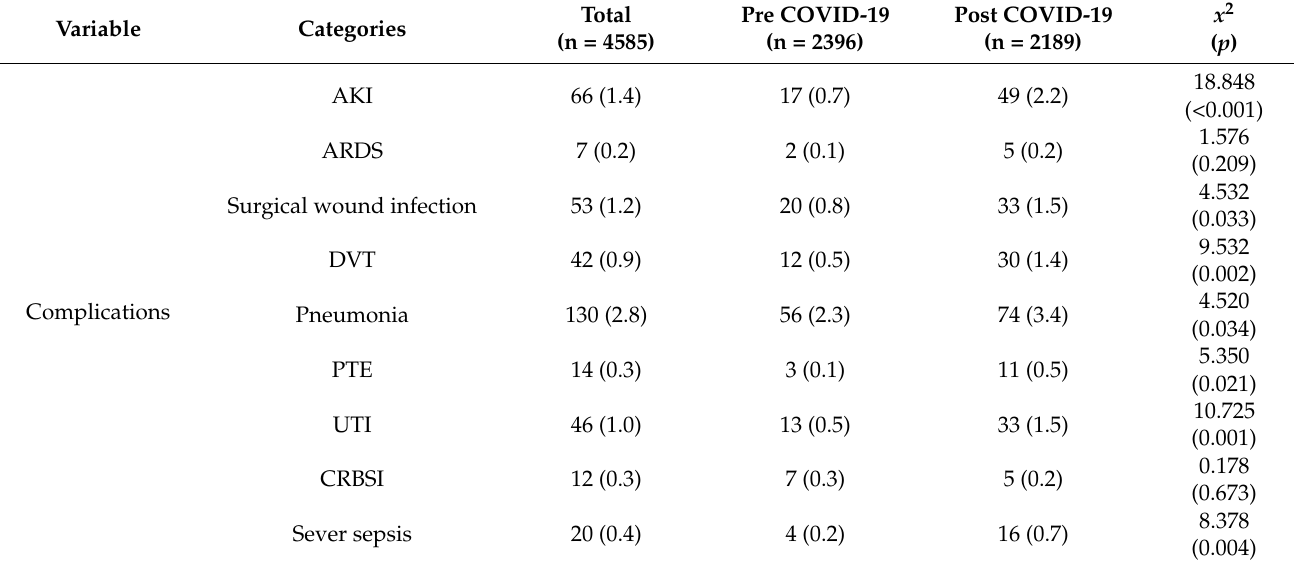
Table 3. Complication rate between the two groups.